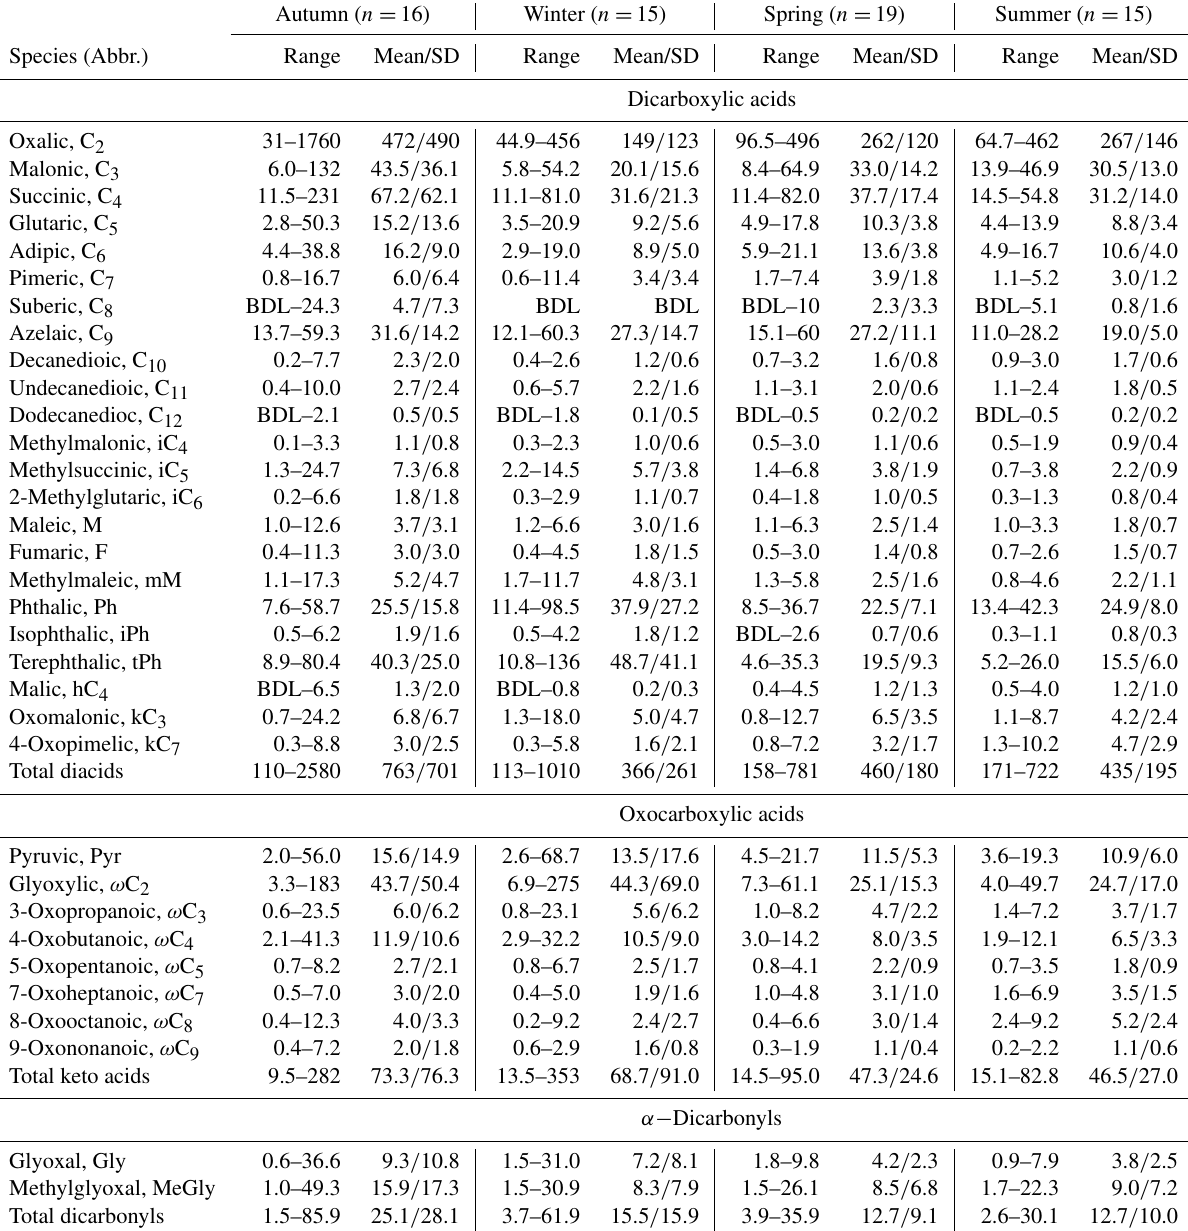
Table 1. Concentrations (ngm − 3 ) of dicarboxylic acids, ketocarboxylic acids and α -dicarbonyls in PM 2 . 5 samples collected in Beijing